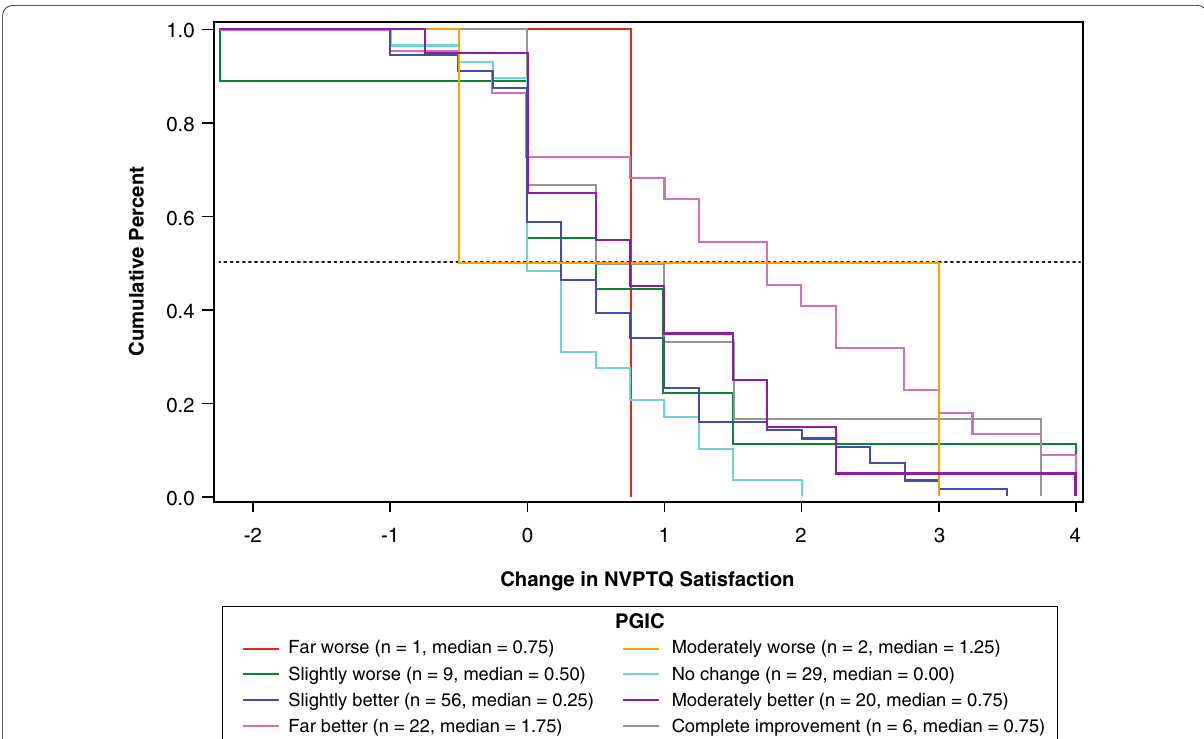
Fig. 8 eCDF of change in NVPTQ Satisfaction by PGIC. Note Change is computed as Day 28 Hour 1 minus Day 1 Hour 0. Positive scores indicate improvement. eCDF, empirical cumulative distribution; NVPTQ, Near Vision Presbyopia Task-based Questionnaire; PGIC, Patient Global Impression of